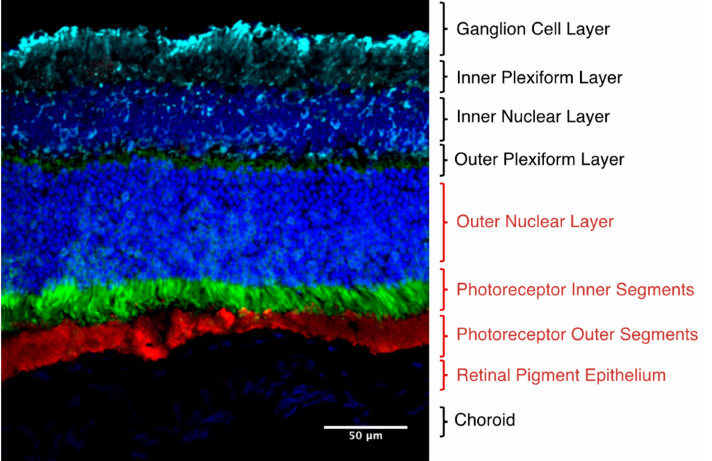
Figure 1. Immunofluorescence section demonstrating the anatomy of a mouse retina. Inherited retinal degenerations a ff ect the cells of the outer retina, particularly the photoreceptors (rods and cones) and the retinal pigment epithelium, highlighted in red text. The inner (green) and outer (red) segments of the photoreceptors are demonstrated with their nuclei stained above in